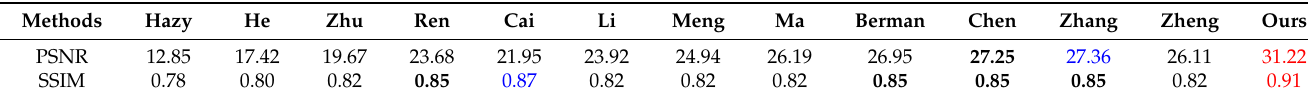
Table 4. Average PSNR and SSIM results on RFSIE. The first, second, and third best results are highlighted in red, blue, and bold, respectively.